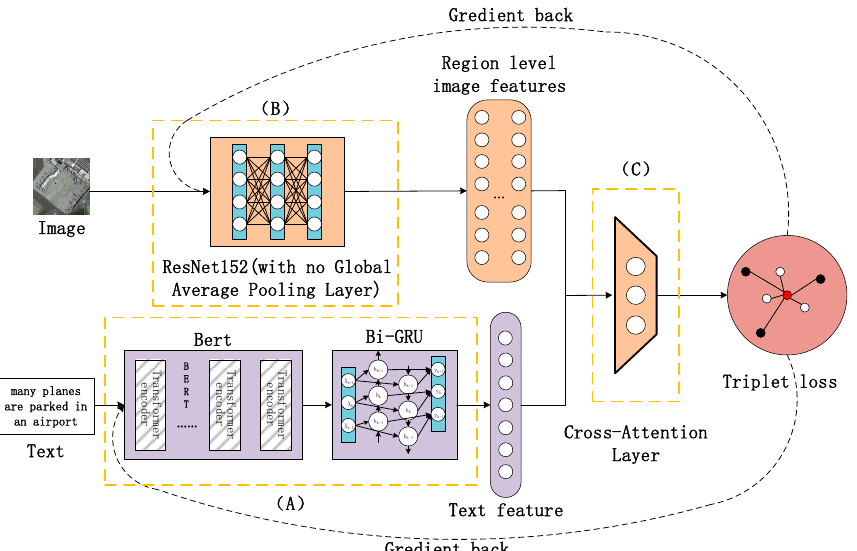
Figure 2. Overall network structure diagram of CABIR. This network consists of three modules, which are: ( A ) the text feature extraction module composed of BERT + Bi-GRU, which is used to extract advanced semantic features of texts; ( B ) the image feature extraction module composed of ResNet152, which is used to acquire regional-level advanced semantic features of images; and ( C ) the CAL module, which is used to filter redundant features of images and solve the similarity matrix between the image set and the text set. Finally, based on this matrix, the model will solve and return the gradient information using the triplet loss to constrain network training.